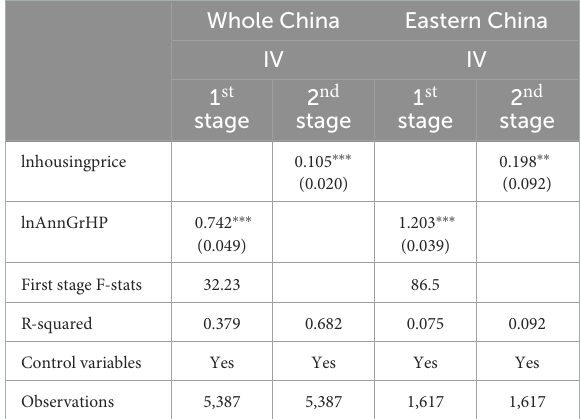
TABLE 5 Effect of housing prices on FLP.